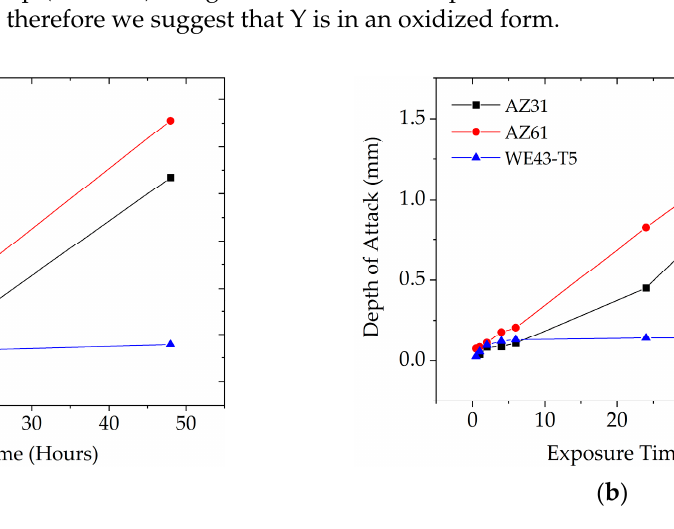
Figure 10. Typical metallographic sections in the longitudinal (L) directions of: ( a ) AZ31 specimen tested for 6 h; ( b ) AZ61 specimen tested also for 6 h; and ( c ) WE43-T5 specimen tested for 24 h.